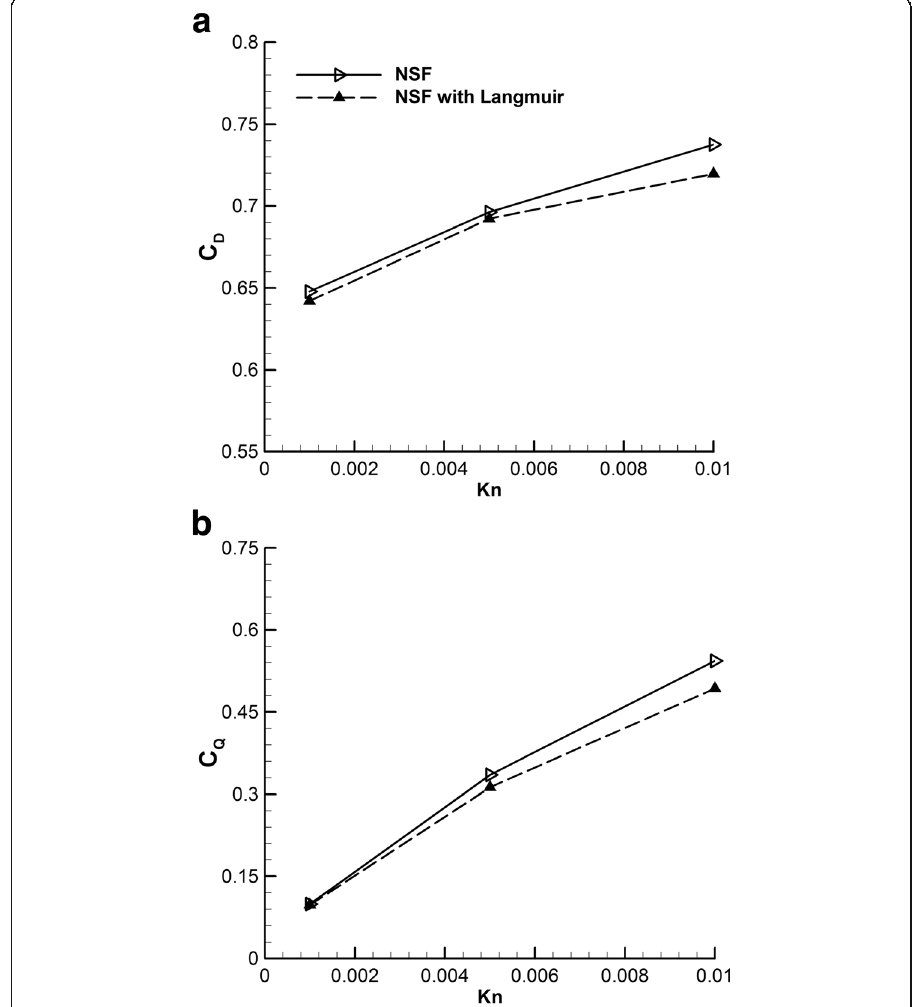
Fig. 19 Comparison of the aerothermodynamic coefficients for varying Knudsen numbers (0.001, 0.005, and 0.01) at M = 6: a drag coefficient, and b heat flux